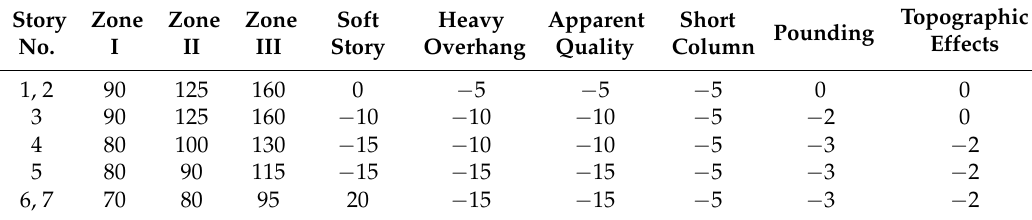
Table 5. Initial and vulnerability scores for concrete buildings given in EMPI [28].